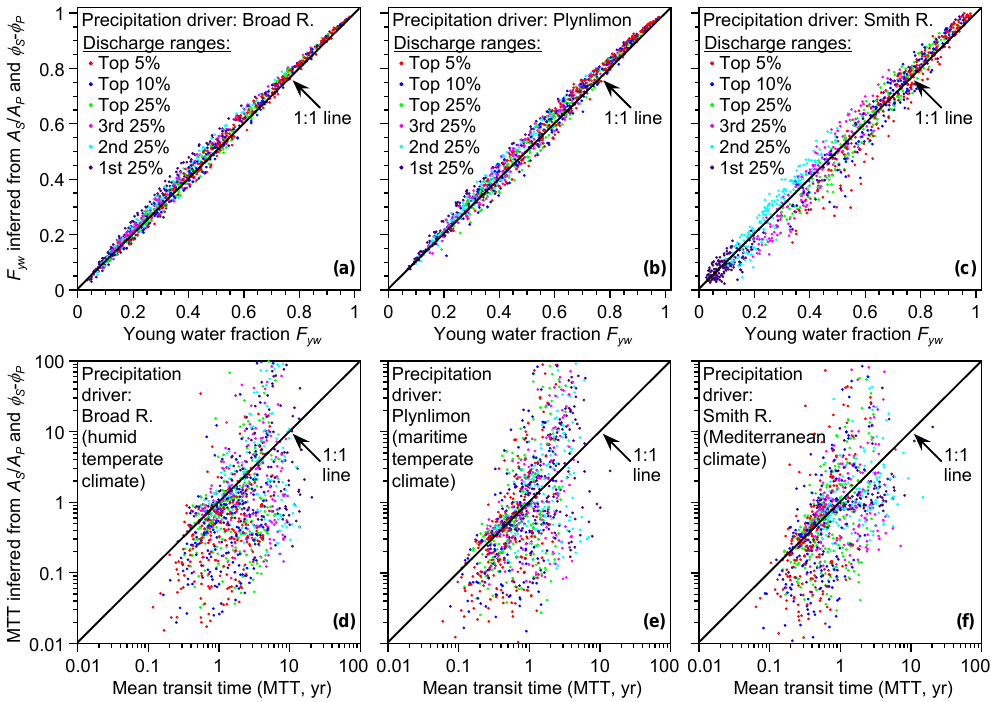
Figure 10. Young water fractions ( F yw ) and MTTs in separate discharge ranges in streamflow from the two-box model. Upper panels compare the time-averaged, flow-specific F yw for each discharge range (measured by age tracking in the model) with F yw values estimated from the amplitude ratios A S /A P and phase shifts ϕ S − ϕ P of the best-fit tracer cycle sinusoids in those discharge ranges (analogously to Fig. 8) using Eqs. (10), (11), (13) and (14) of Paper 1. Similar results (not shown) are also obtained for flow-weighted F yw and flow-weighted tracer cycle sinusoids. Results obtained from tracer cycle amplitude alone (without phase information) are also similar, except in some cases where the amplitude ratio is small (particularly with Smith River precipitation forcing). Lower panels compare the MTT, determined by age tracking, with the MTT inferred from tracer amplitude ratios and phase shifts using Eqs. (10) and (11) from Paper 1. Each panel shows results from 200 random parameter sets and three contrasting precipitation drivers: Broad River (humid, temperate, with very little seasonality), Plynlimon (wet maritime climate with slight seasonality), and Smith River (Mediterranean climate with pronounced winter-wet, summer-dry seasonality). Tracer cycle amplitudes and phases generally predict the young water fractions in each discharge range, although with some modest scatter. Mean transit-time estimates, by contrast, are highly unreliable, exhibiting large scatter (note log